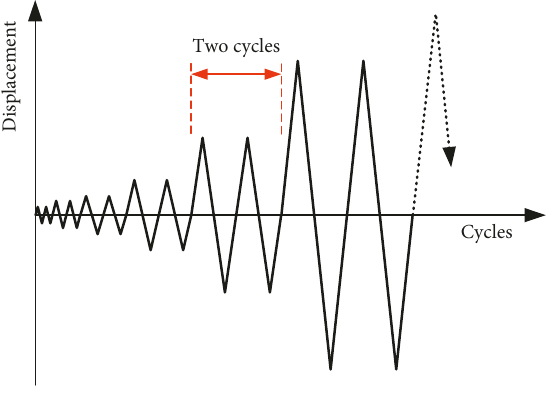
Figure 5: Loading